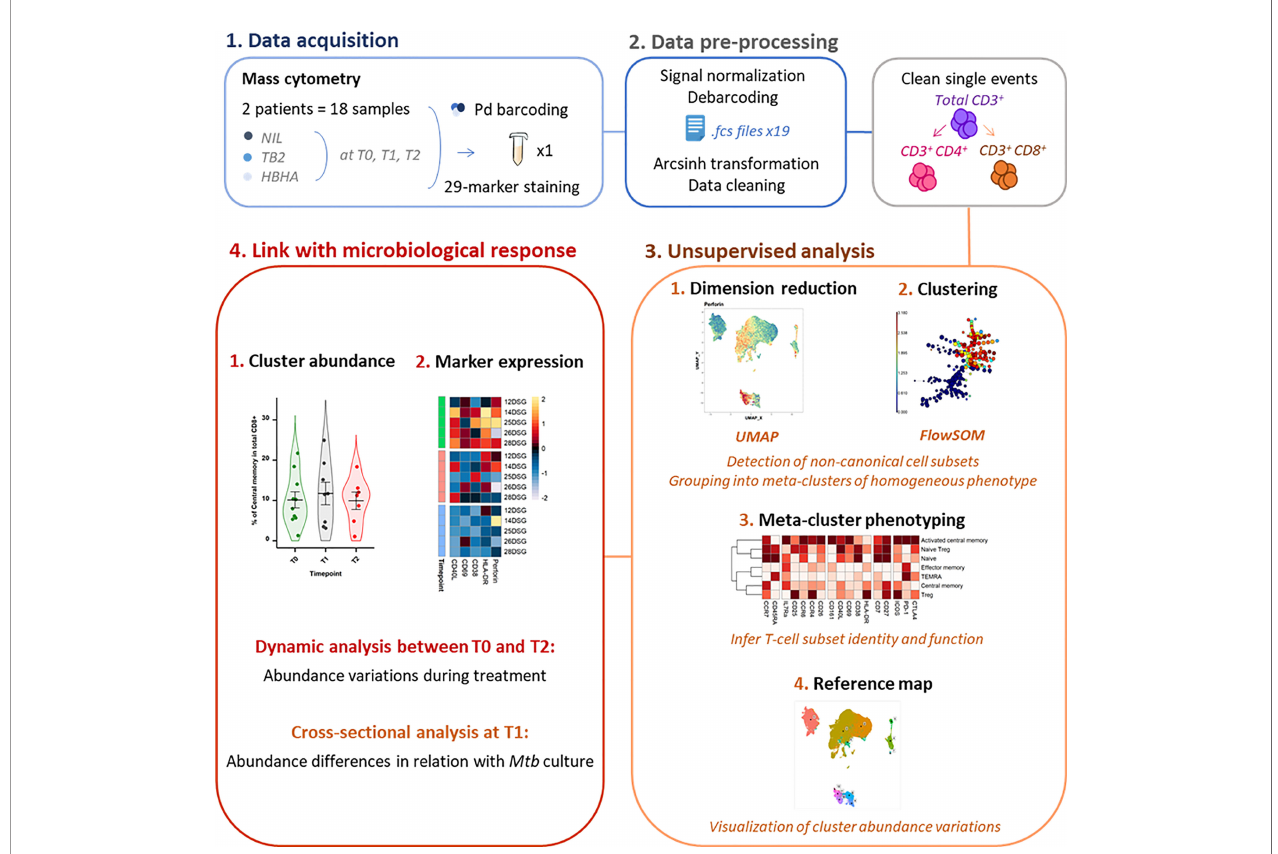
FIGURE 1 | Experimental and analytical work fl ow. Peripheral whole blood samples were collected from active TB patients (n = 22) throughout treatment (T0: baseline. T1: T0 + 2 months. T2: end of treatment). After whole blood stimulation with Mtb antigens (TB2 and rmsHBHA) or with a negative control (NIL), total white blood cells were extracted. After palladium (Pd) barcoding for unique sample identi fi cation before multiplexing, T-cells were analyzed with a 29-marker mass cytometry panel. TB2, Qiagen QuantiFERON TB2 tube (ESAT-6 + CFP-10 + undisclosed CD8 + T-cell stimulating peptide pool); rmsHBHA, recombinant heparin- binding hemagglutinin obtained in Mycobacterium smegmatis ; UMAP, Uniform Manifold Approximation and Projection; FlowSOM, self-organizing